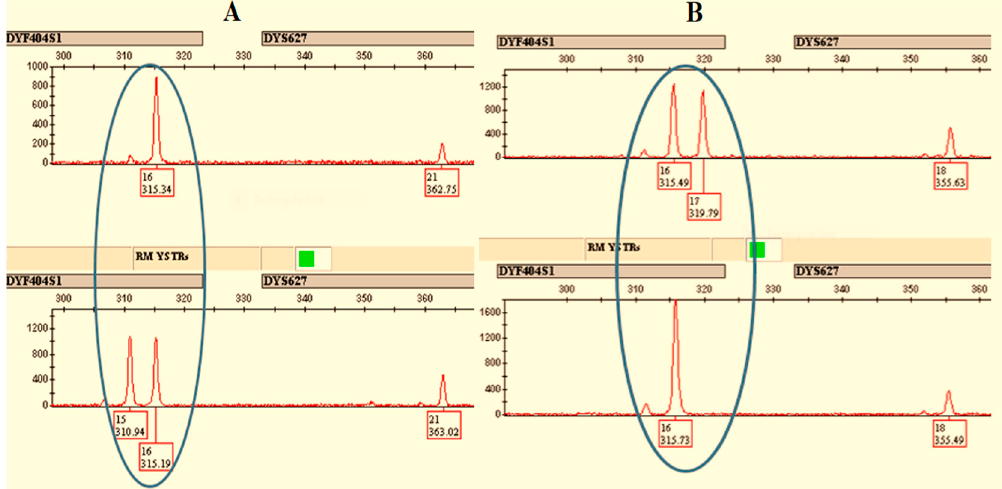
Figure 3. Electropherograms showing mutations observed at various RM Y STR loci for ( A ) a father– son pair and ( B ) a brother–brother pair, where the mutation occurs at the duplicated locus DYF404S1. Circles indicate probable mutation events. Table 4. Mutation events observed at various RM Y STR loci.